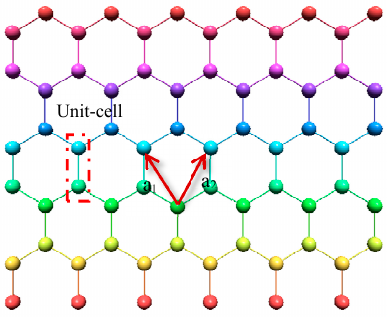
Figure 2. Schematics geometry of the 2D-graphene layer.